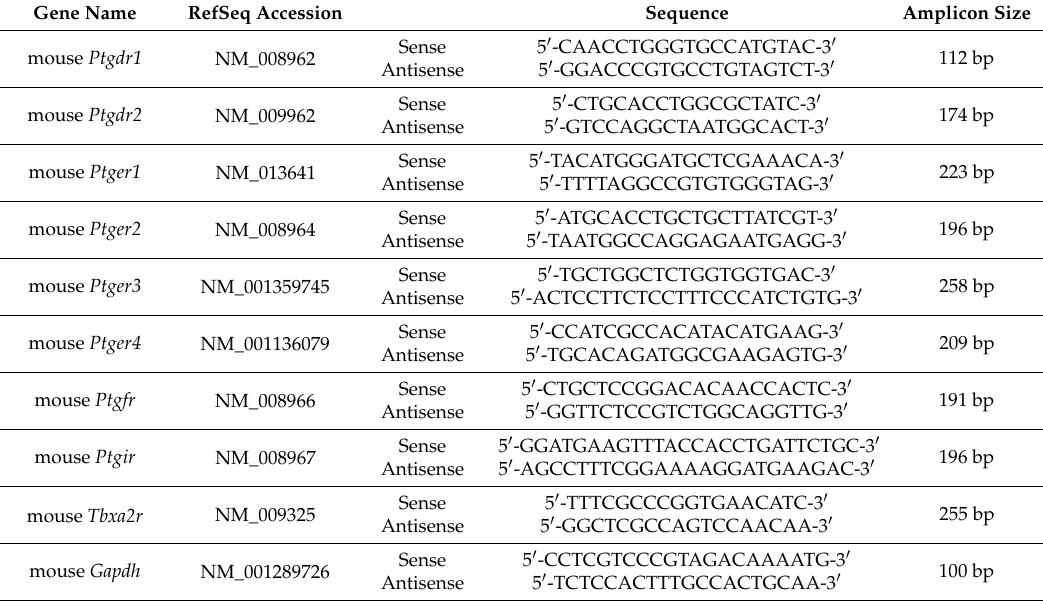
Table 2. Primer sequences for RT-PCR used in the present study